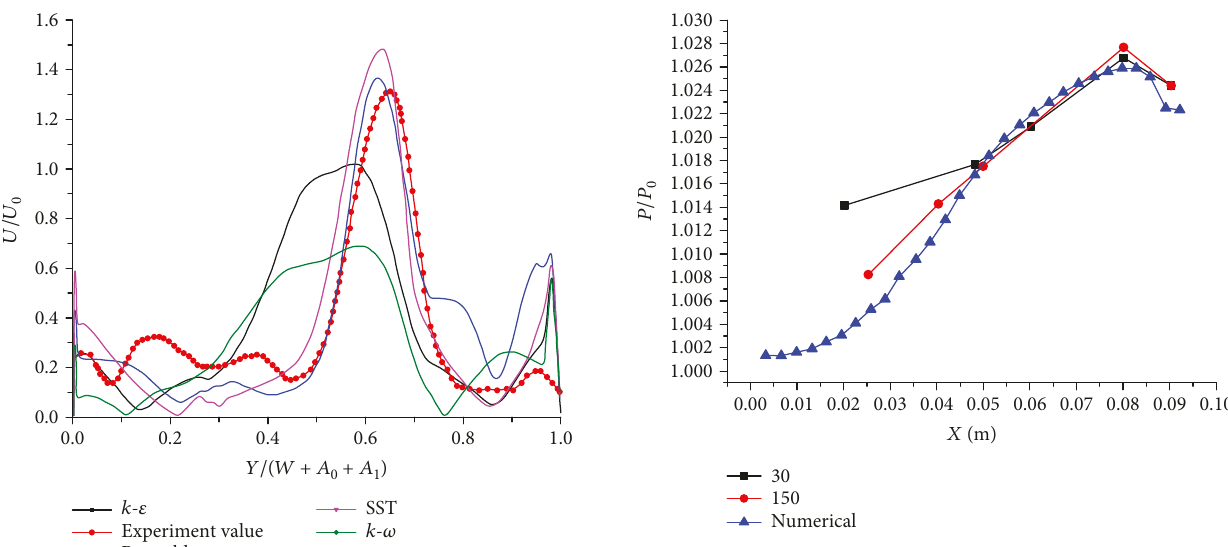
Figure 14: Pressure distribution on the under wall of predi ff user.